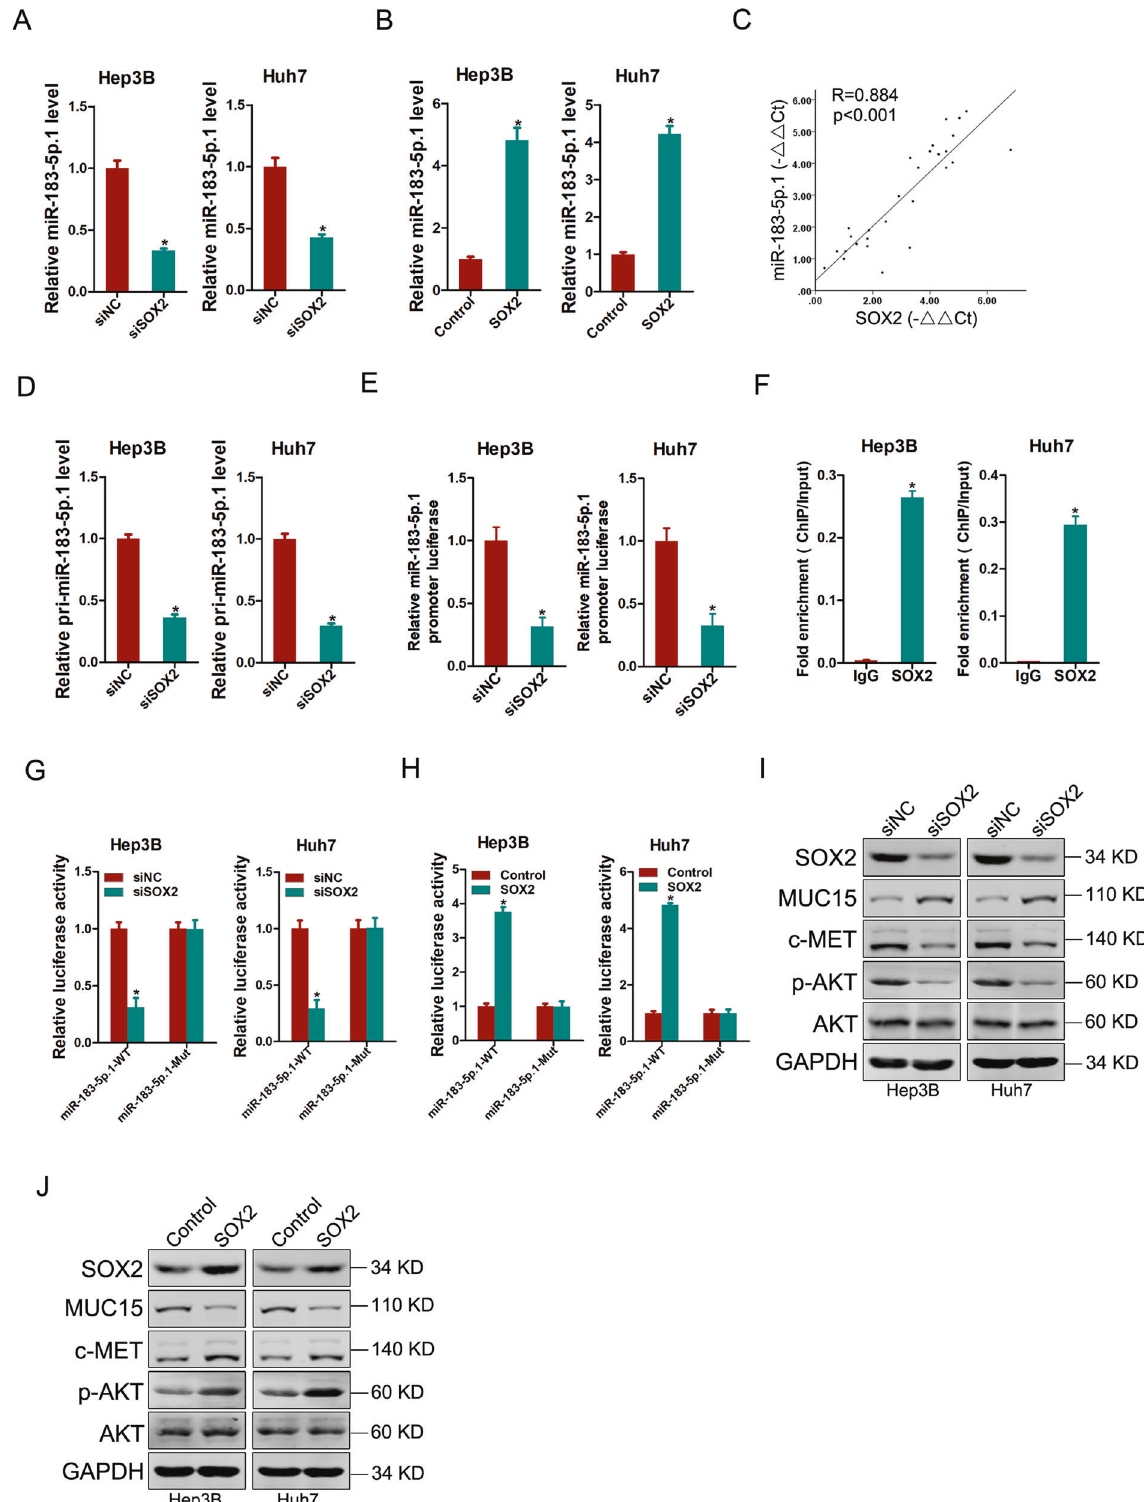
MUC15/c-MET/ PI3K/AKT/SOX2 axis could be a novel therapeutic strategy for HCC. Existing evidences are showing that miRNA expression is dysregulated in T-ICs and contribute to T-ICs expansion [8, 23]. We hypothesized that the loss or gain of miRNAs targeting MUC15